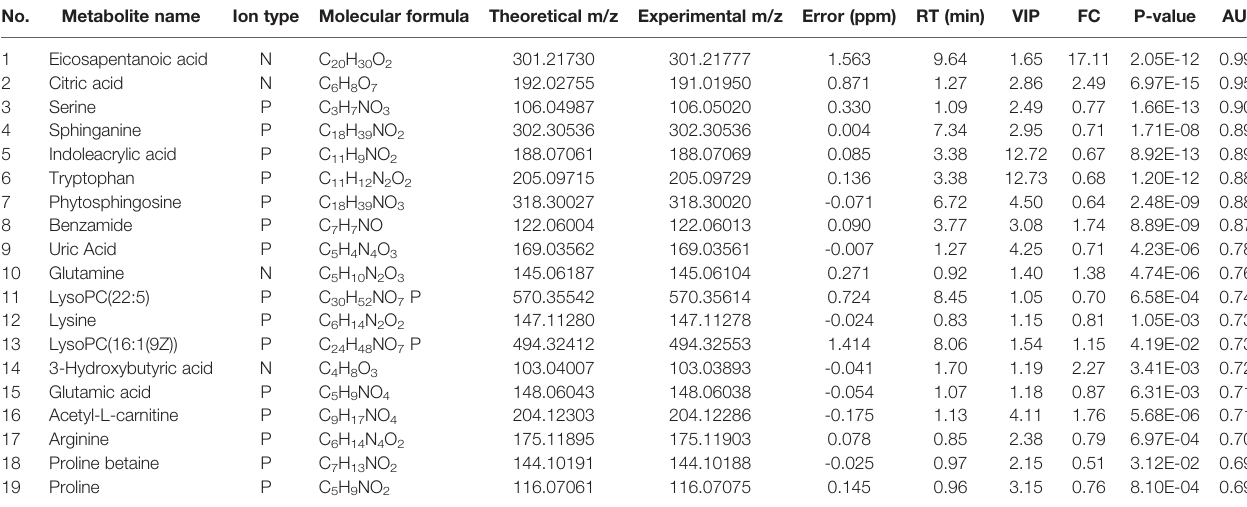
FIGURE 3 | Metabolite volcano analysis diagram of EOLP group and HC group (A) , ROLP group and HC group (B) , EOLP group and ROLP group (C) in the negative ion mode; and EOLP group and HC group (D) , ROLP group and HC group (E) , EOLP group and ROLP group (F) in the positive ion TABLE 2 | Differential metabolites between EOLP group and healthy group.